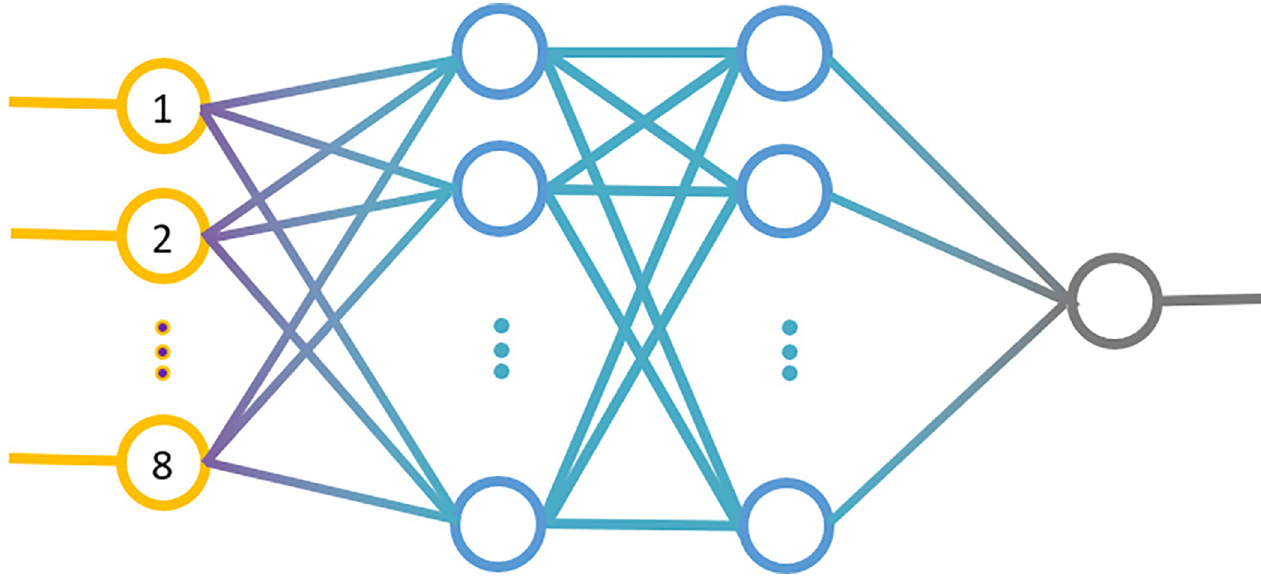
Fig 2. An illustration of the network used to predict the horses’ position in the